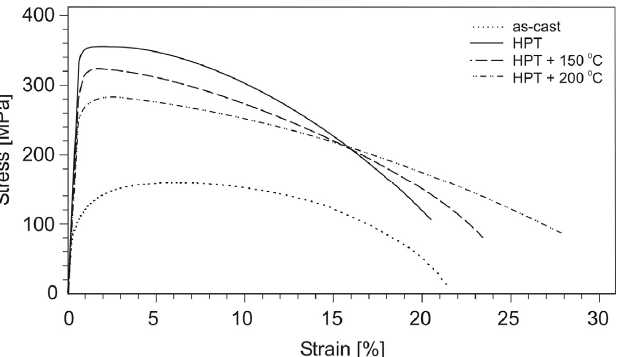
Figure 7. Stress–strain curves for tensile test specimens of the Al–10% La alloy in as-cast state, after HPT, and subsequent annealing.